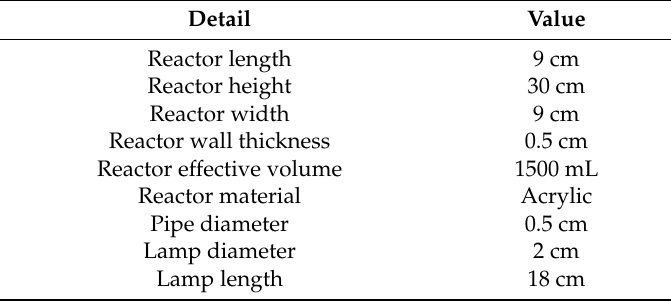
Table 4. Description of the continuous-flow photocatalytic